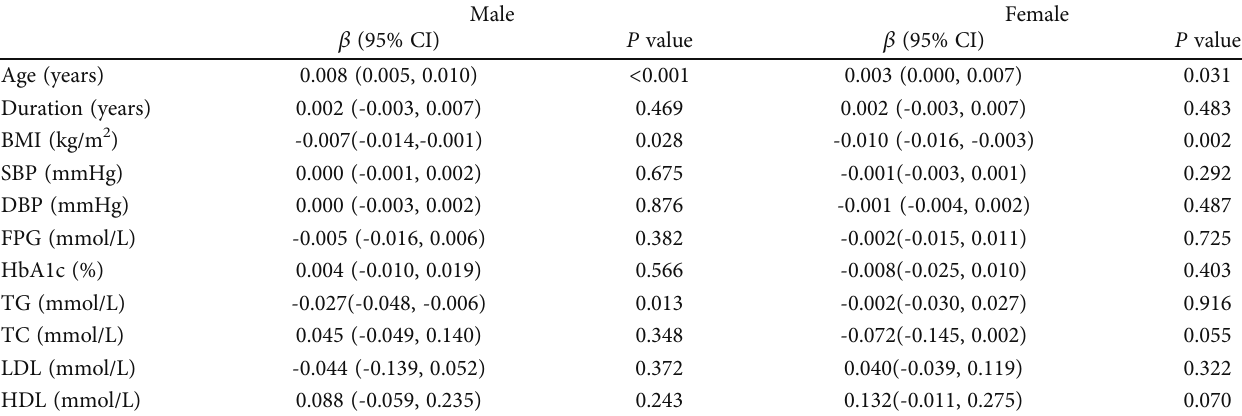
Table 4: The correlation between ALT/AST and clinical